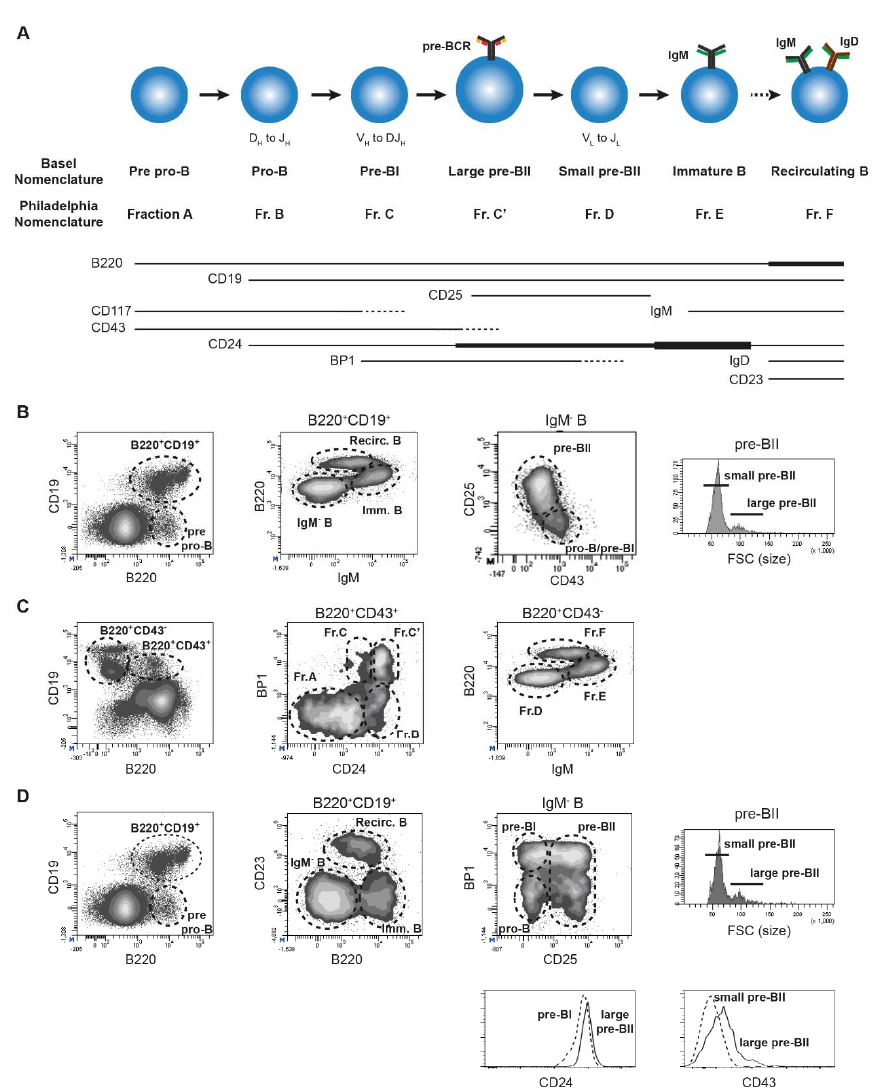
Figure 2. Murine bone marrow (BM) B cell differentiation. ( A ) Schematic representation of the different B cell differentiation stages with their denomination according to the Basel and Philadelphia nomenclatures. The pattern of expression of the main markers used to characterize each subset is shown with a line. The thickness of the line is representative of the level of expression. The dotted lines indicate subsets where expression is progressively lost. VDJ H and VJ L rearrangements are indicated; ( B ) BM B lymphopoiesis analysis by flow cytometry according to the Basel nomenclature; ( C ) BM B lymphopoiesis analysis by flow cytometry according to the Philadelphia nomenclature. The